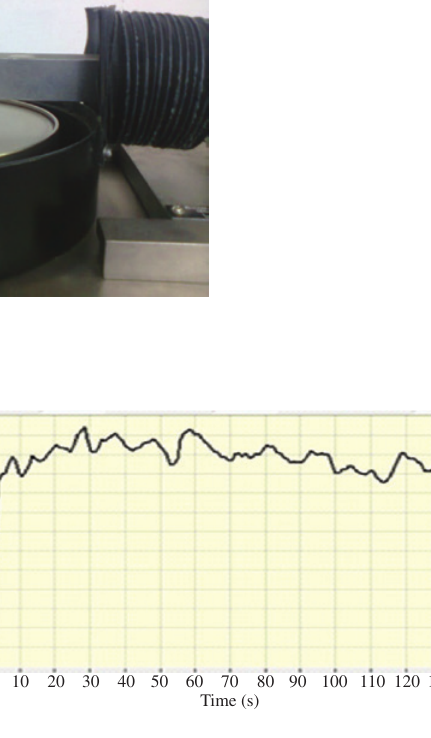
Figure 6: Graph generated at the time of the wear test on the pin- on-disc machine for coefficient of